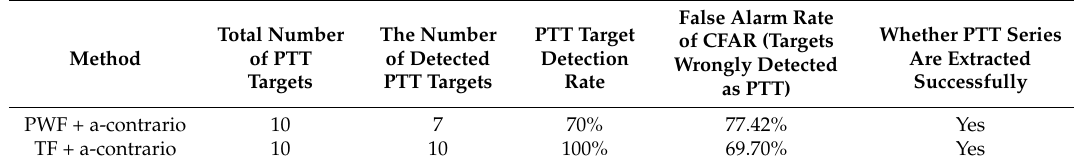
Table 2. Results comparison of two methods in Experiment I.